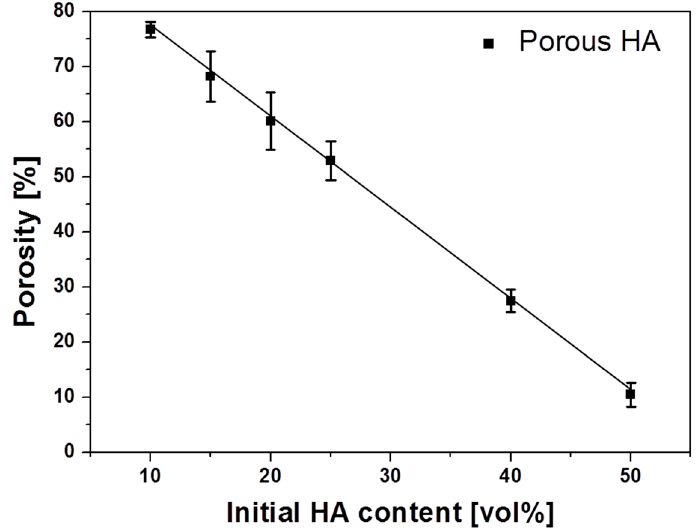
Figure 4. Porosity of porous HA scaffolds as a function of initial HA content.